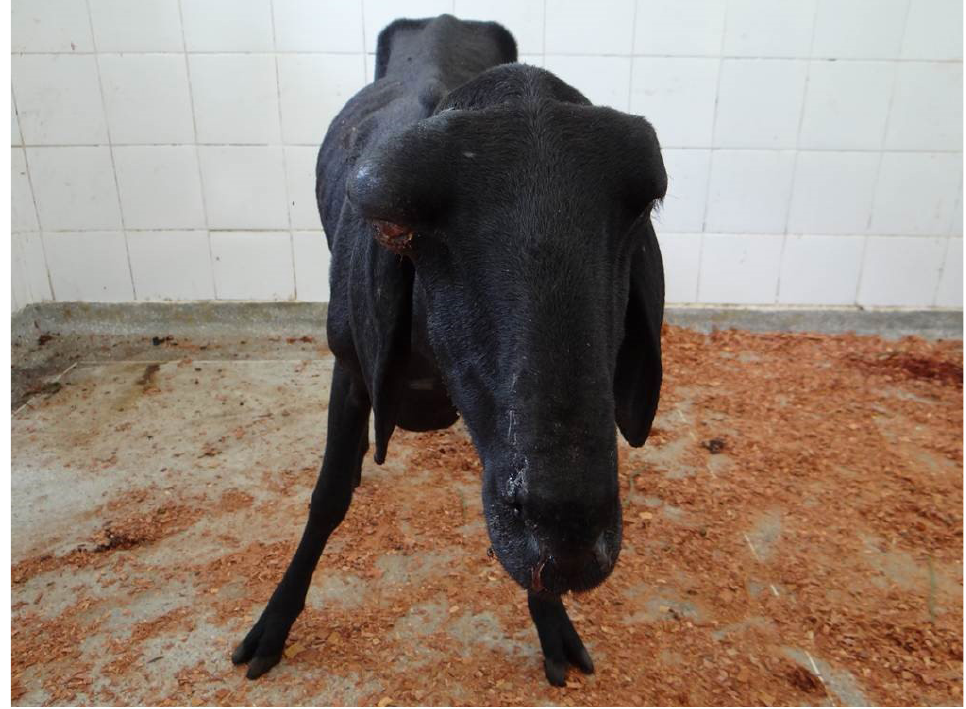
figura 1. Conidiobolomicose em ovino (2PS). Notar baixa condição corporal, assimetria craniofacial, exolftalmia direita e posição de cavalete.